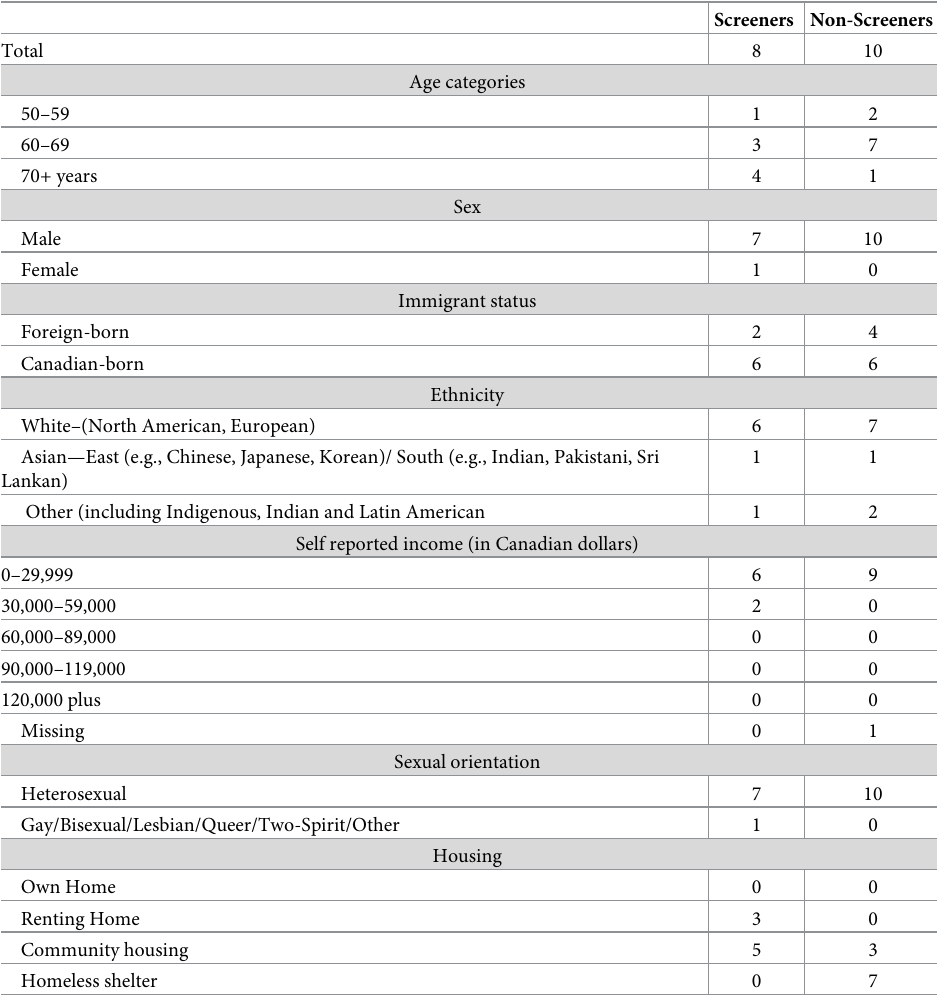
Table 1. Participant sociodemographic